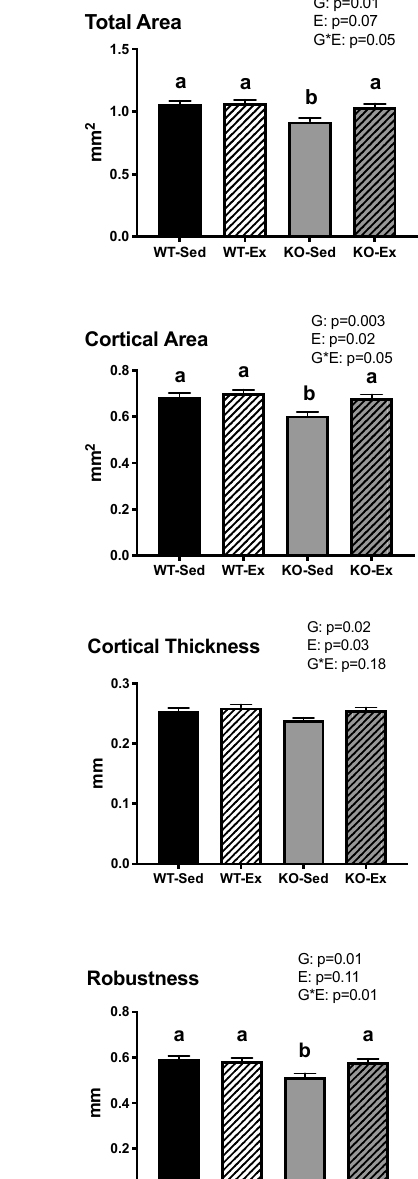
Figure 1. Tibial cortical geometry. Cortical geometry of the tibia. Data are adjusted means ± SEM,